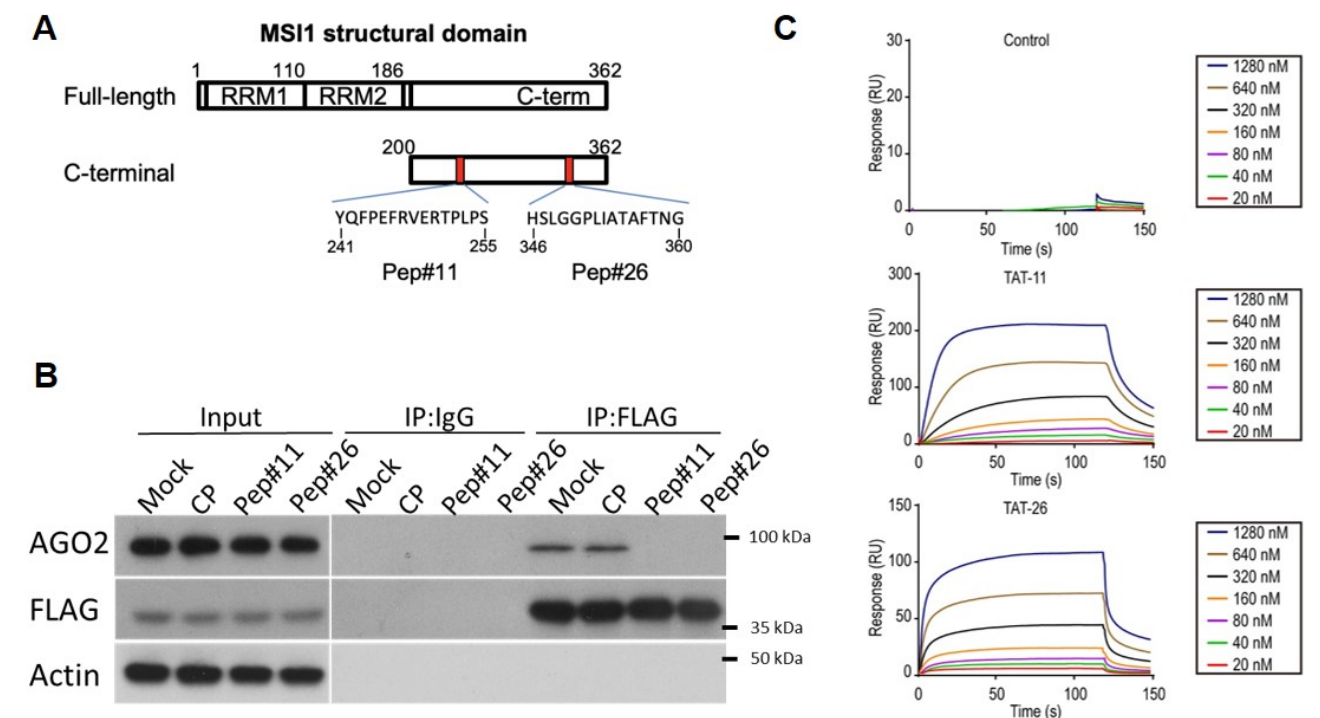
Figure 3. Identification of peptidic motifs from the C-terminus of MSI1 that mimic interaction function with AGO2. ( A ) Structural domain of MSI1 (full-length and truncated C-terminus). ( B ) Cells respectively treated with 10 μ M of the two decoy peptides (Pep#11 and Pep#26) or peptide control (CP) were subjected to Co-IP immunoblot to demonstrate the efficacy of the two peptides on blocking the MSI1/AGO2 interaction under hypoxic condition. ( C ) Binding interaction between Pep#11, Pep#26 and their target protein AGO2 was determined by surface plasmon resonance (SPR). The recombinant AGO2 protein was immobilized on CM5 chip and incubated with a serial dilution (from 20 to 1280 nM) of the two peptides as well as a negative control peptide. The association rate constant (ka), dissociation rate constant (kd), and equilibrium dissociation constant (KD) were calculated and presented in Table S2.